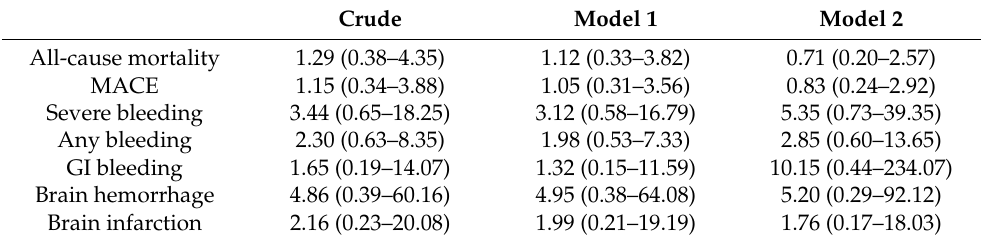
Table 4. Comparison of apixaban anticoagulation and no